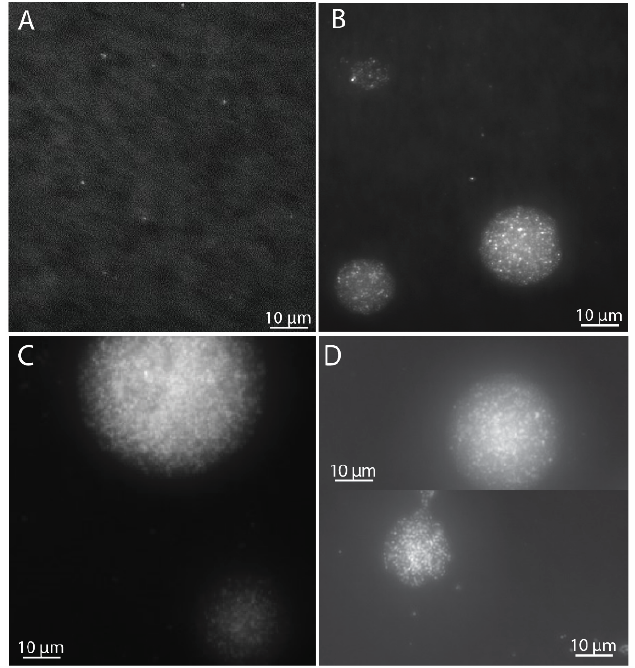
Figure 1. Microcolony growth of M. gorgona MG08 at different times during pre-incubation and gas uptake experiments. ( A ) Cells after filtration on polycarbonate filters, prior to incubation. ( B ) Microcolonies after 4 months of pre-incubation under ambient air. ( C ) Microcolonies after 8 months of pre-incubation under ambient air. ( D ) Microcolonies after 9 months of pre-incubation under ambient air and 57 days of gas uptake experiment incubation under synthetic air (( D ), upper panel), and synthetic air + 2–4 p.p.m.v. CH 4 , CO and H 2 (( D ), lower panel). For fixation, the filters were transferred to fresh-made 2% paraformaldehyde in 1 × PBS in the refrigerator overnight. For staining, filters were transferred (side with bacteria up) on top of 200 µ L droplets of 1000 × SYBRgreen I (10 × dilution of the stock concentration provided by Thermo Fisher Scientific, Invitrogen, Molecular probes) and incubated for 10 min, washed, and air